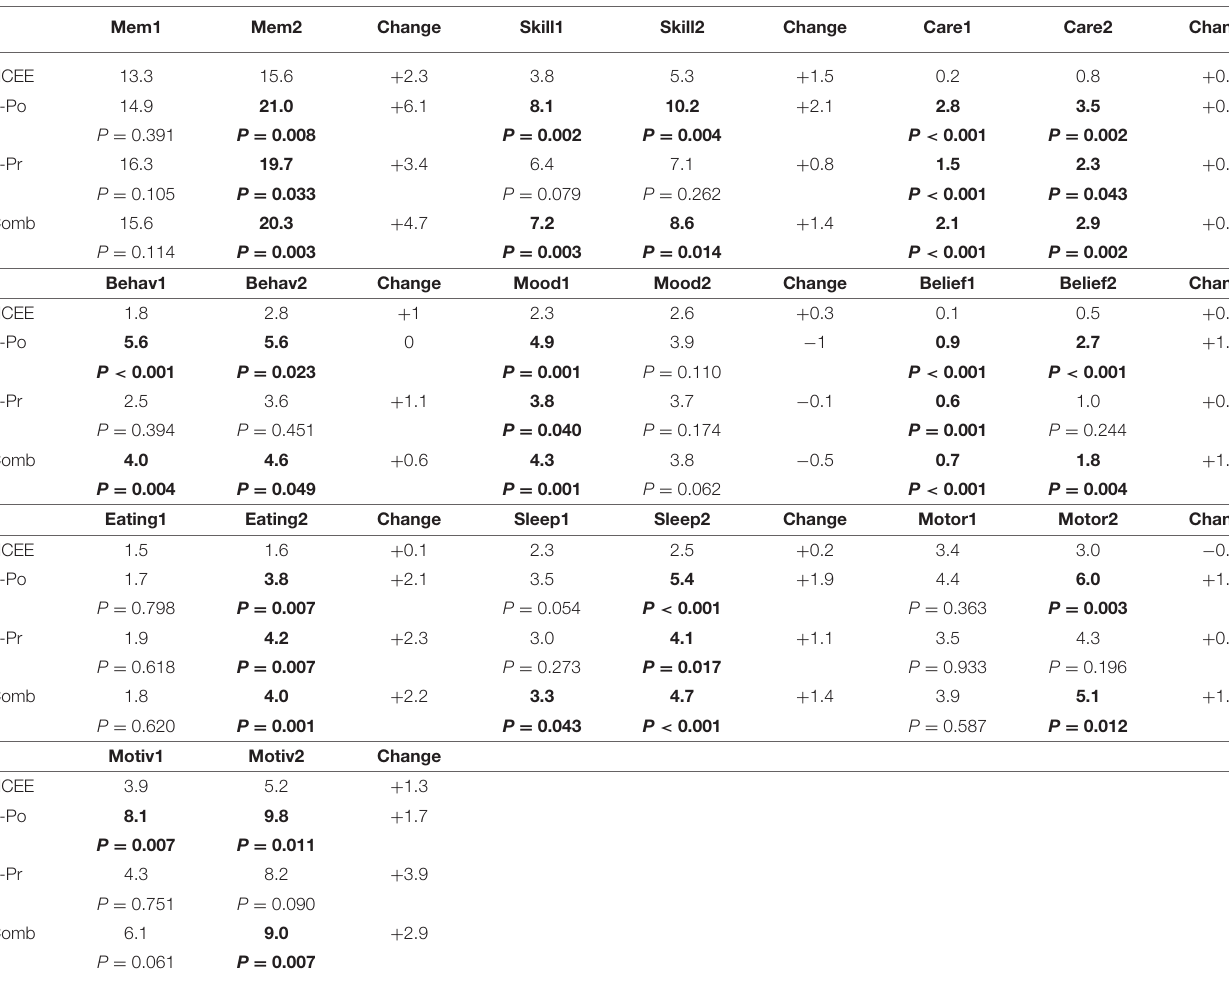
TABLE 6 | Mean changes in CBI-R domain scores in AD participants between baseline and follow-up assessments (higher scores indicate greater impairment), bold figures indicate significant difference ( p < 0.05) when compared to NCEE